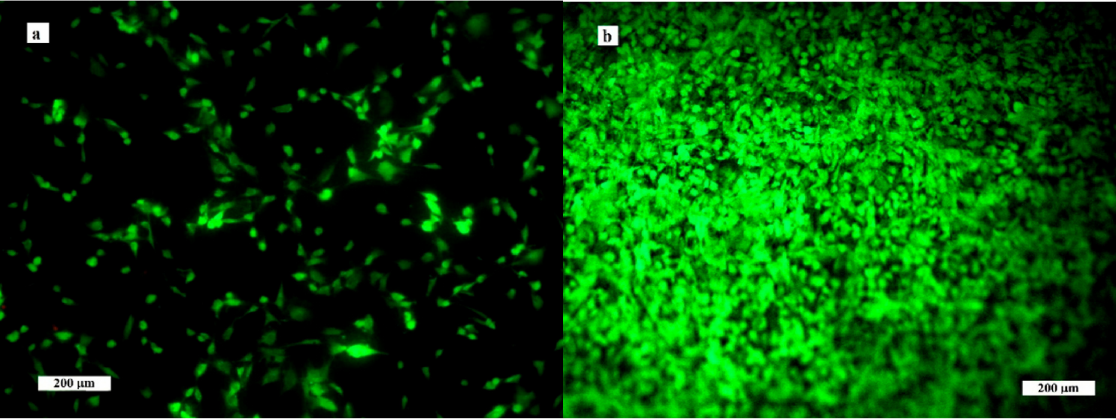
Figure 6. Distribution and morphology of osteoblasts cultured on ceramic samples for 2 ( a ) and 9 ( b ) days (live/dead